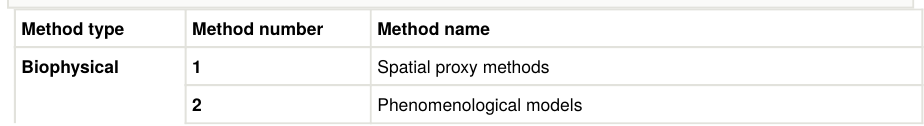
Overview of the ecosystem service mapping and assessment methods proposed in